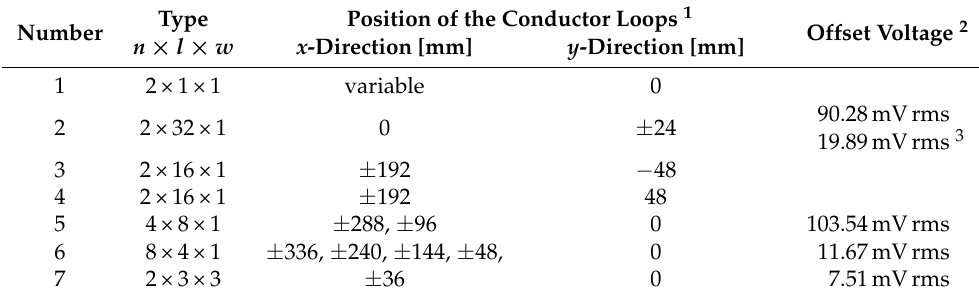
Table 5. Used sensor coil geometries.